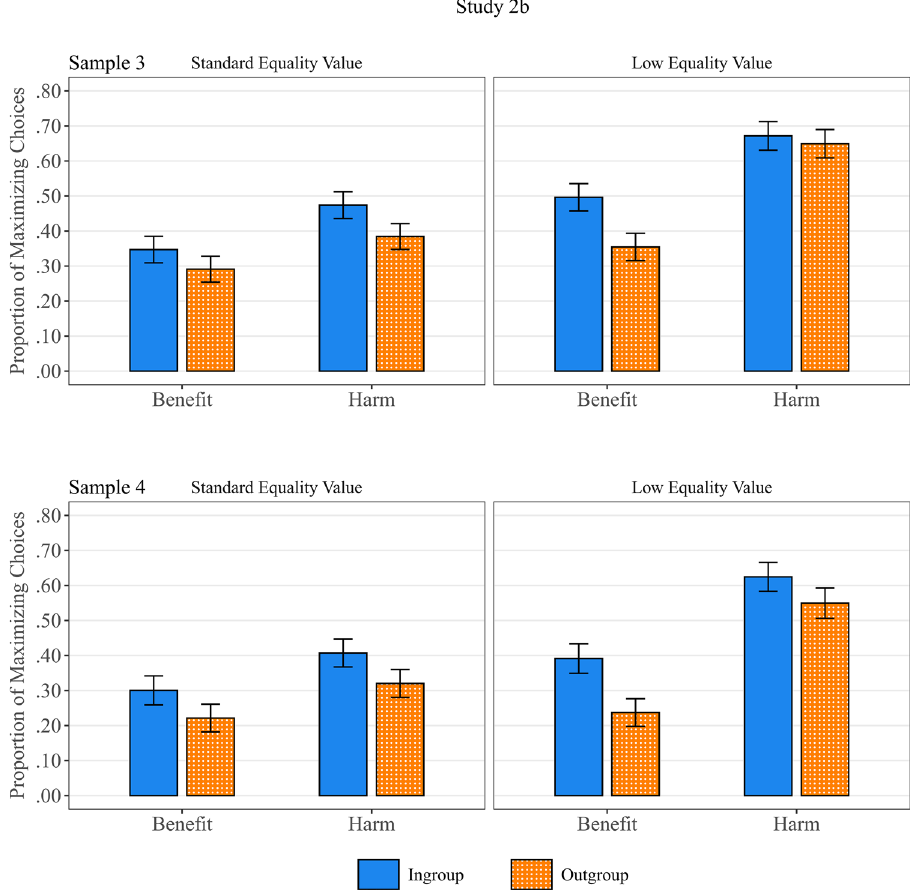
Figure 4. Proportion of Maximizing choices as a function of target group (all Ingroup versus all Outgroup), type of outcome (Benefit versus Harm), and Equality Value (Standards versus Low), for Sample 3 and Sample